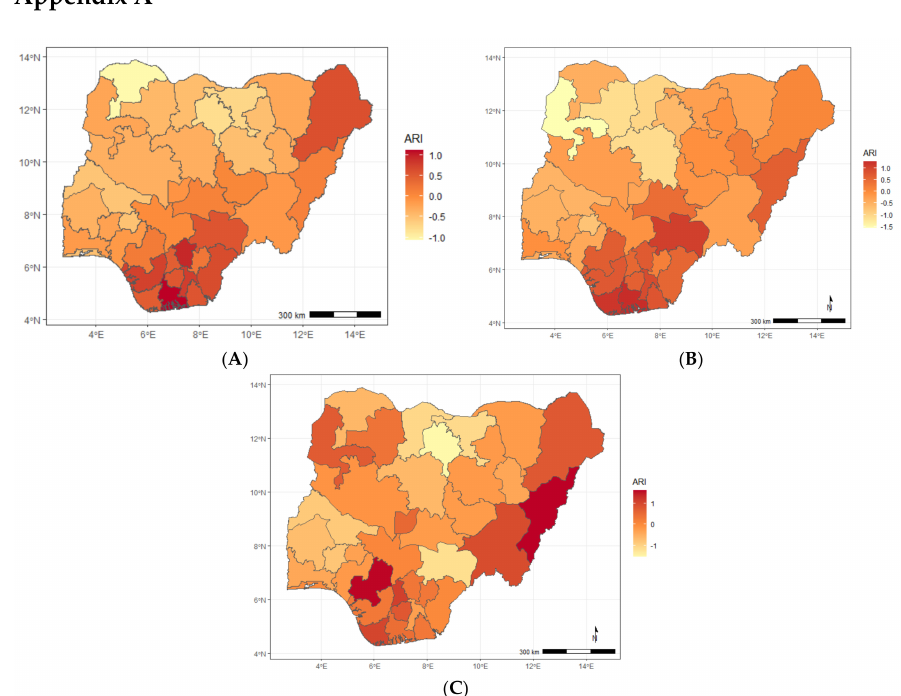
Figure A1. Maps showing posterior estimates of ARI-specific spatial effect by year of NDHS imple- mentation; ( A ) 2008, ( B ) 2013, ( C ) 2018.